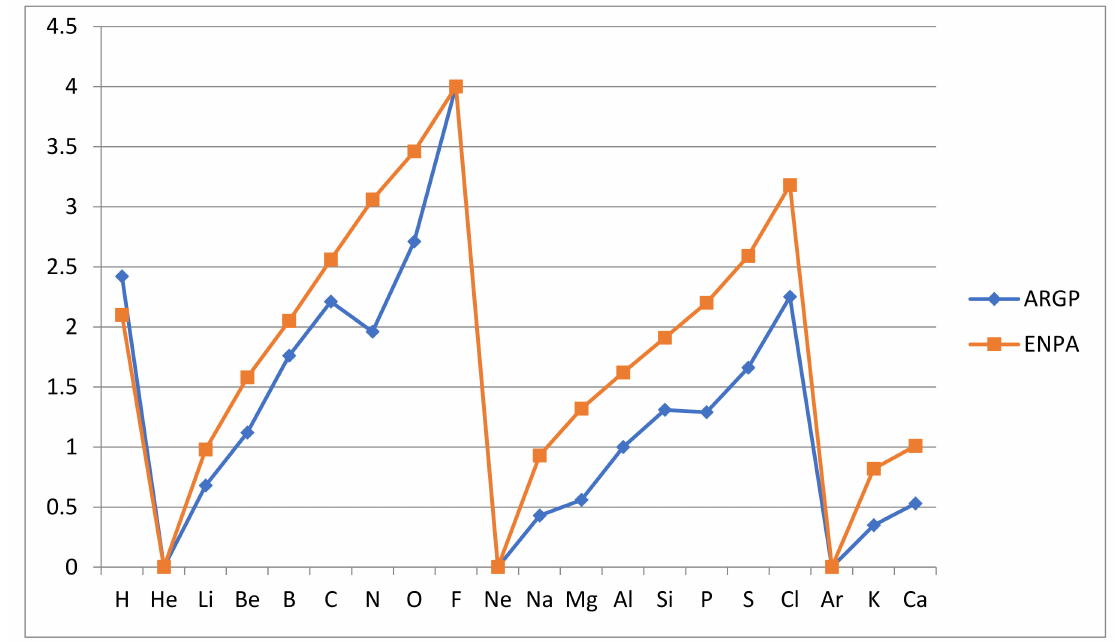
Figure 4. Comparison of relative reactivity rAR GP (ARGP) and Pauling/Allred negativities (ENPA) for the atoms from hydrogen to calcium. Note that the electronegativities have been set to zero for He, Ne and Ar, while normally considered undefined for inert gas